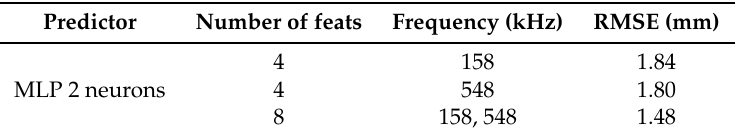
Table 5. Results of real